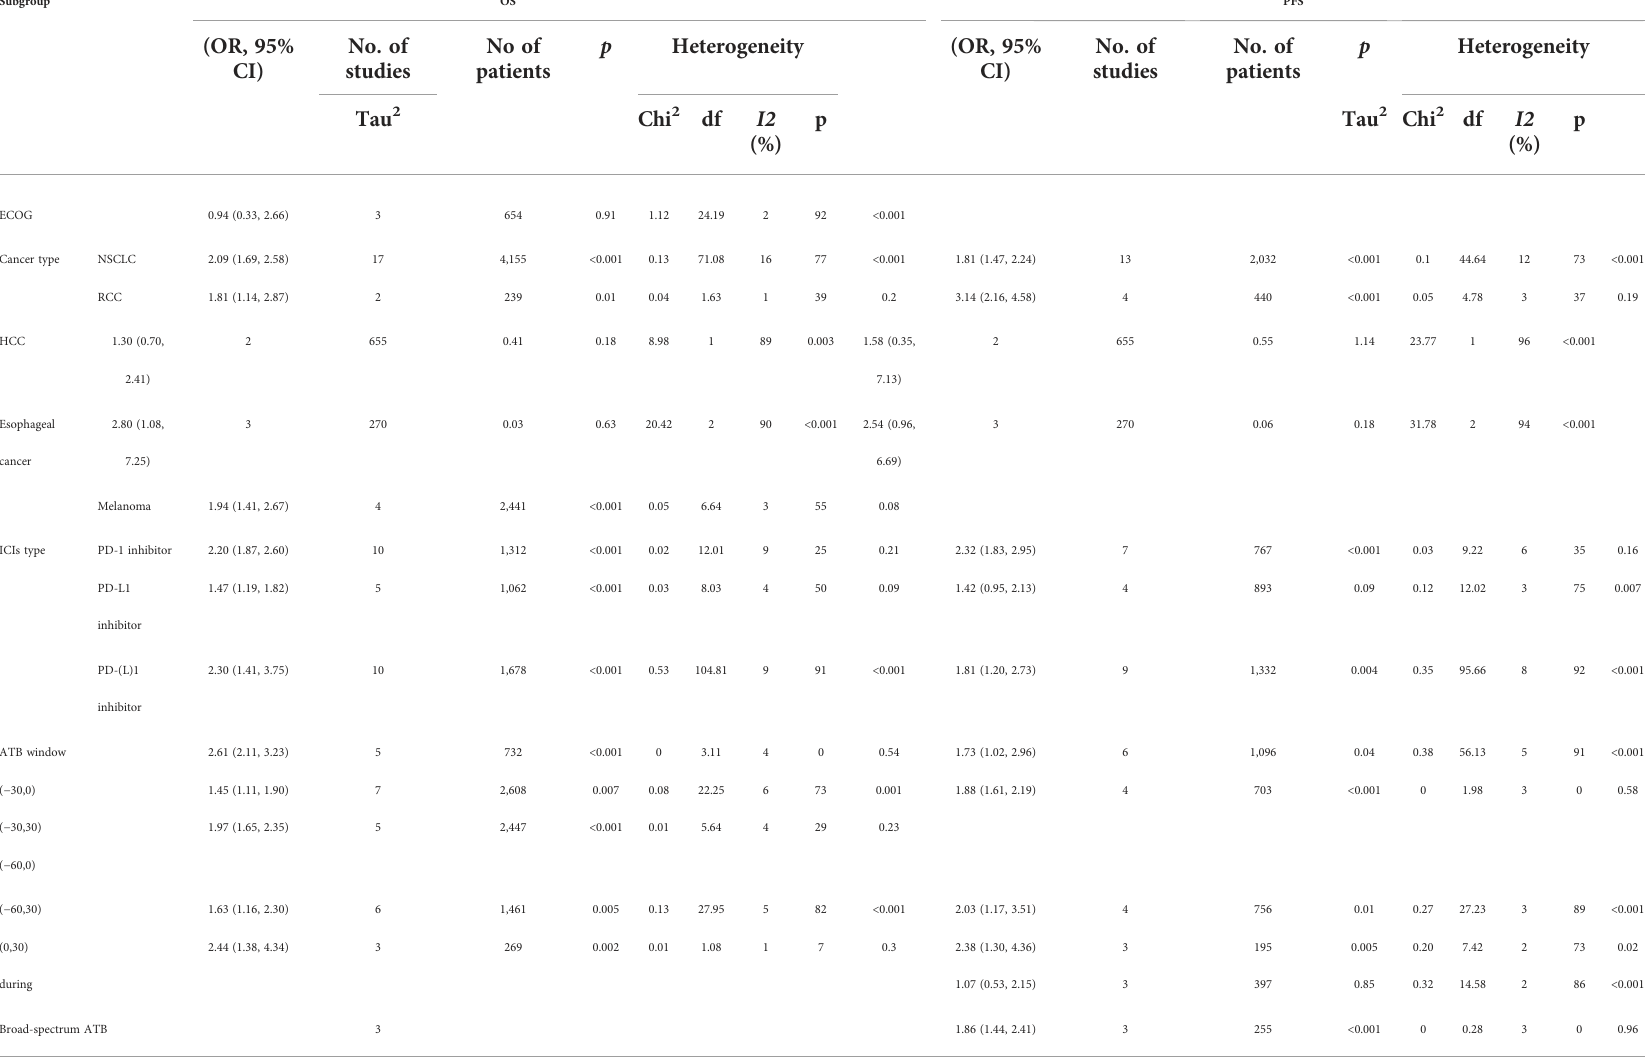
Subgroup OS PFS